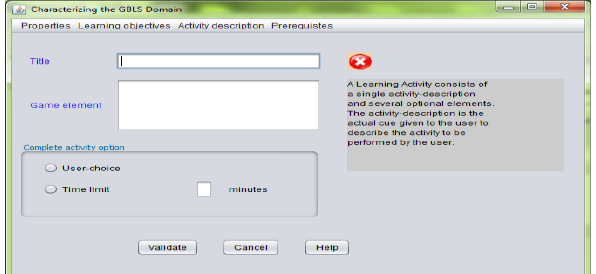
Figure 6. The user interface for characterizing GBLS domain